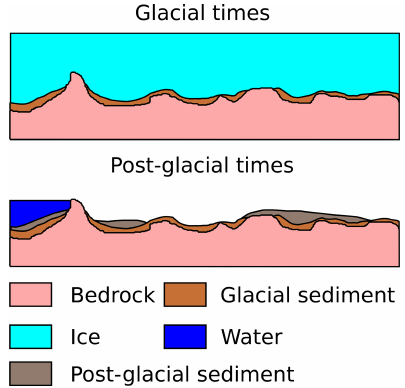
Figure 1. Illustration showing the relationship between the bedrock, glacial sediments and postglacial sediments. In glacial times, the ice sheet is in contact with glacial sediments created by the ice sheet itself and bedrock. In post-glacial times, the bedrock and glacial sediments can be obscured by water bodies and post- glacial